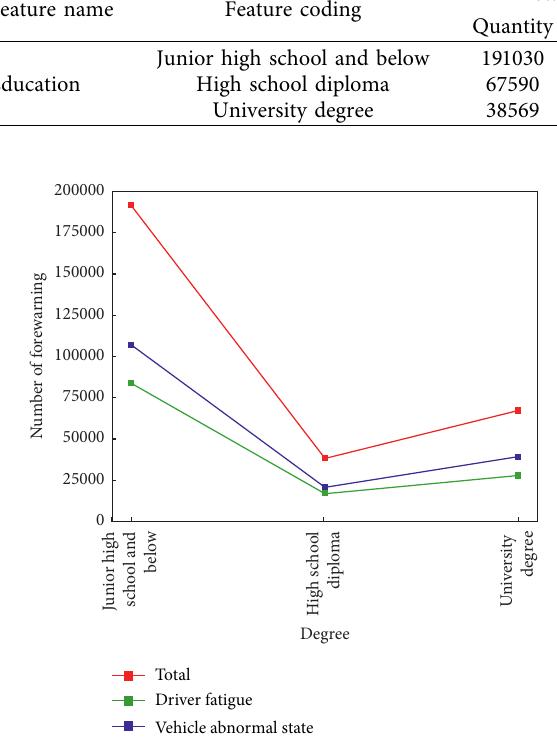
Figure 14: Distribution of forewarning types for drivers with different degrees.